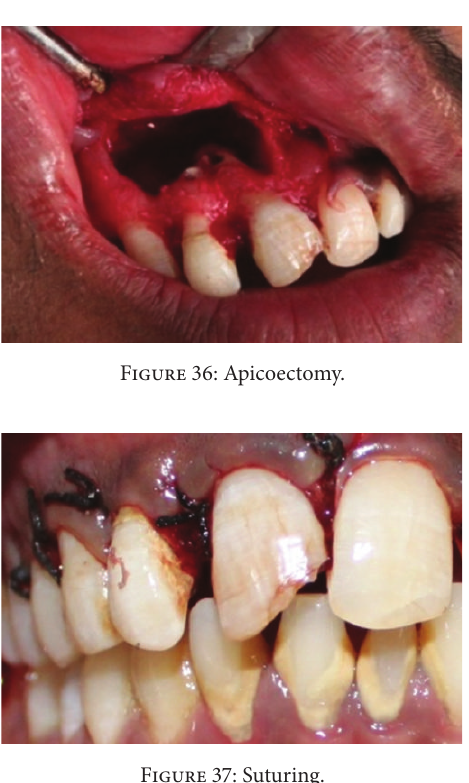
Figure 37: Suturing.